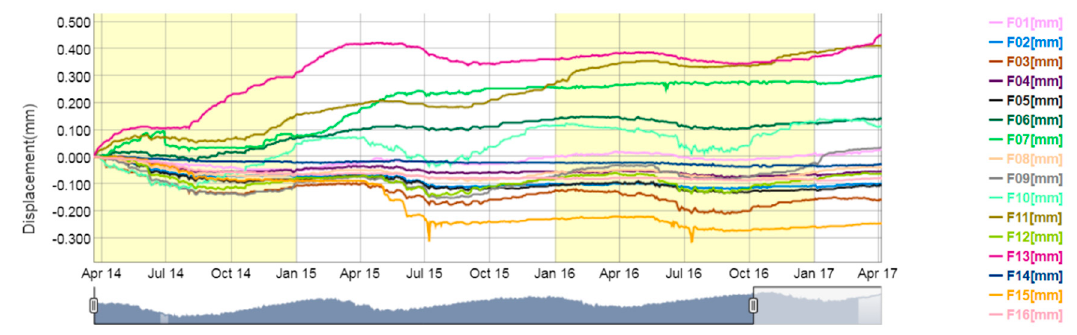
Figure 8. Displacement recorded by the crackmeters deployed across the tunnel cracks—the graph has been produced directly through the web-based platform.